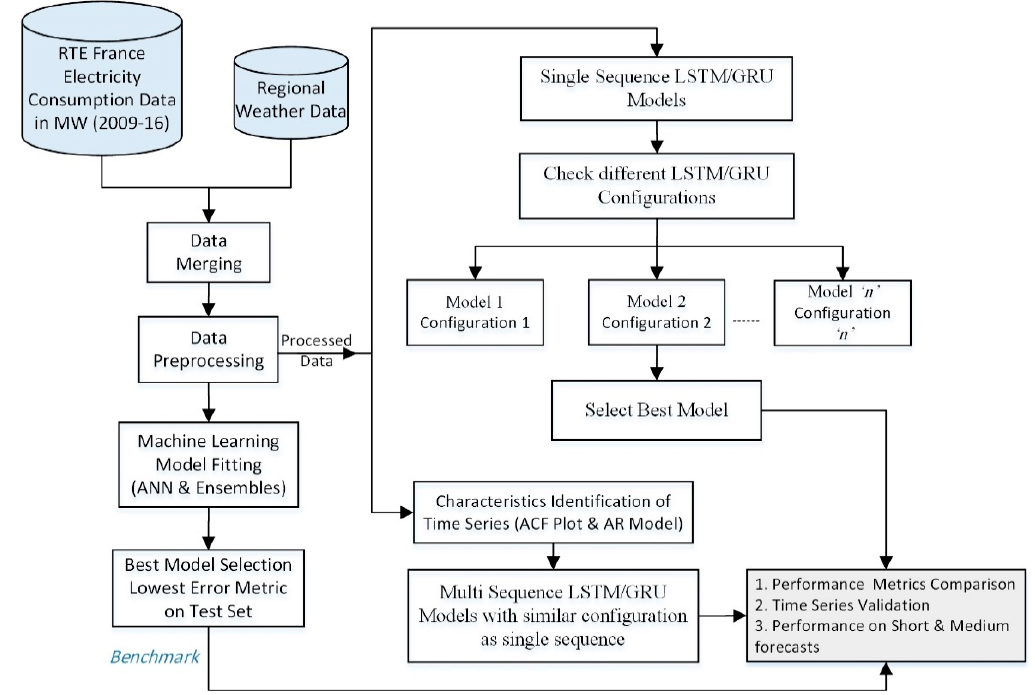
Figure 4. Proposed forecasting methodology.